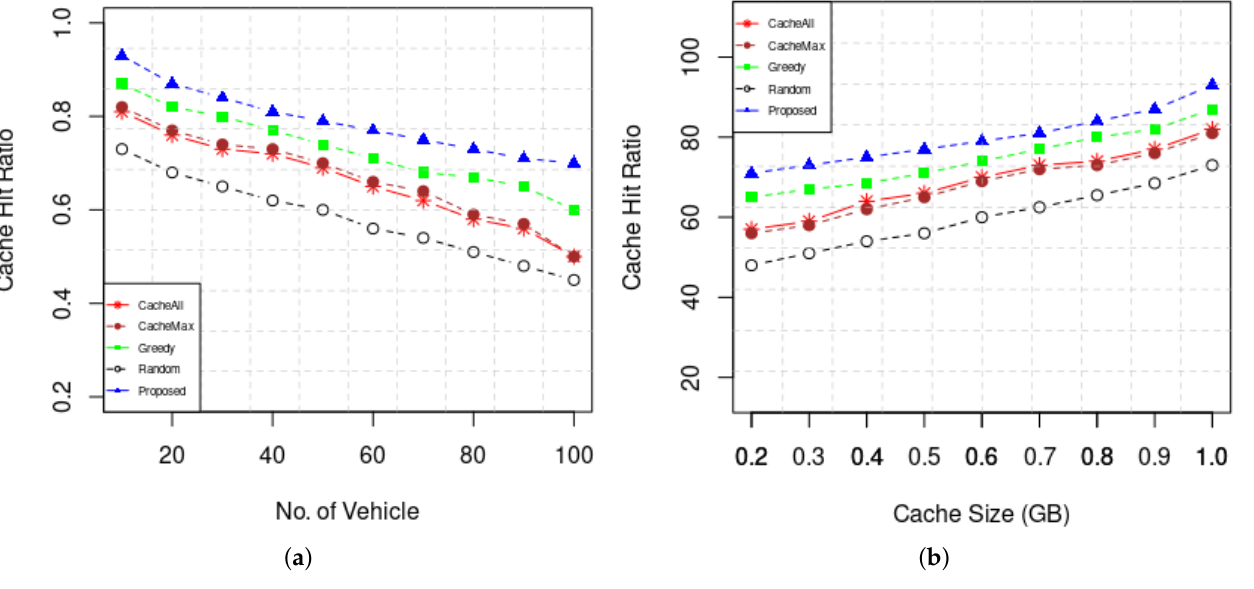
Figure 6. ( a ) Cache Hit ratio vs. No. of vehicles ( b ) Cache hit ratio vs. different cache